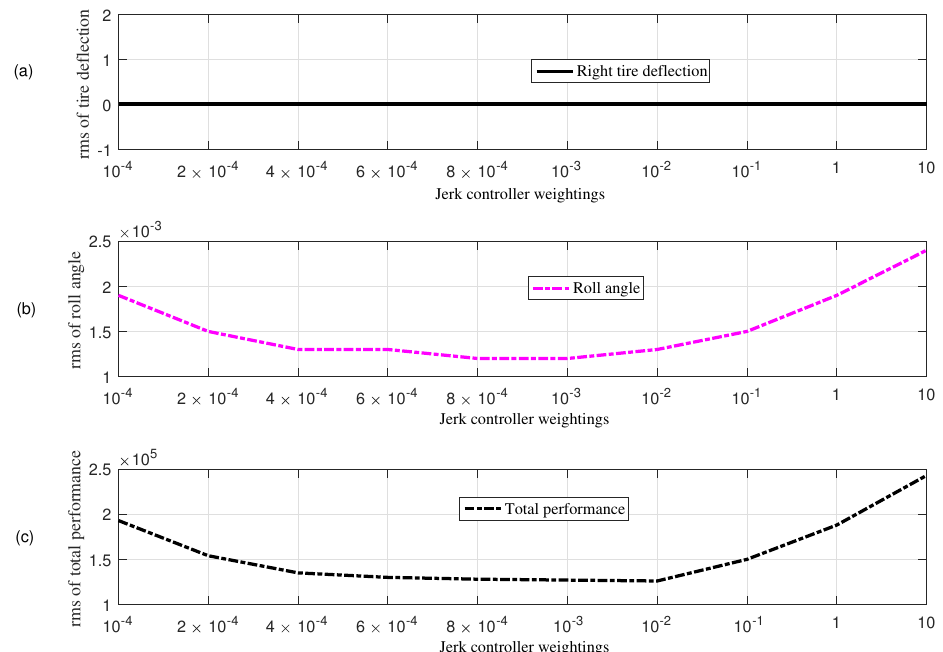
Figure 4. Comparison based on rms values obtained using different weights in the presence of bump velocity input; ( a ) tire deflection ( b ) roll angle ( c ) total